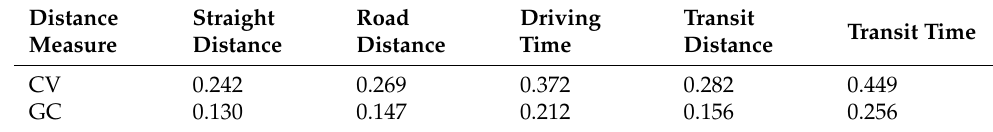
Table 1. Spatial inequality in health care accessibility by various distance